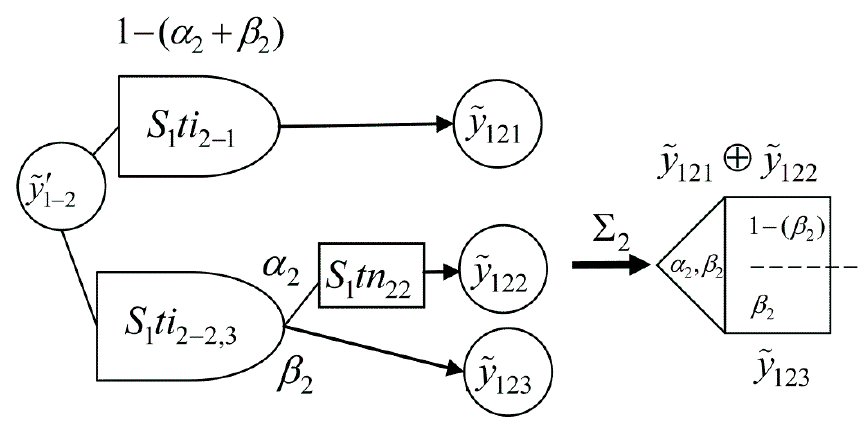
Figure 3. Parameterized model fragment and its aggregation.